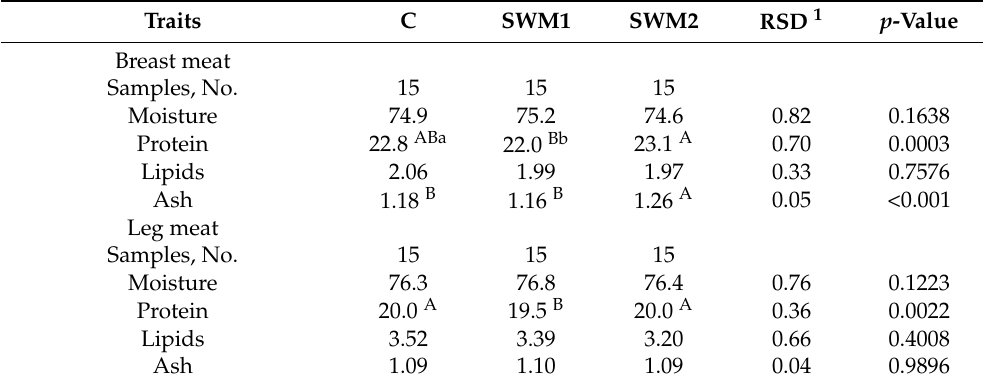
Samples, No. 15 Moisture